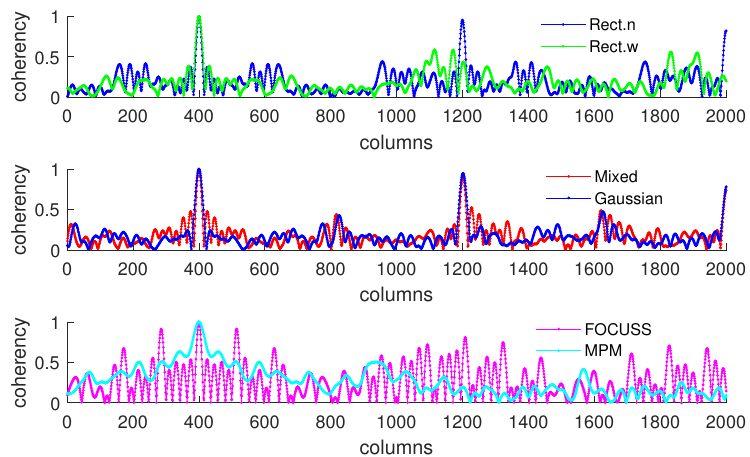
Figure 13. Coherence curves and positions of elements in each subarray generated in Simulation 3 at direction θ = arcsin ( 0.2 ) .